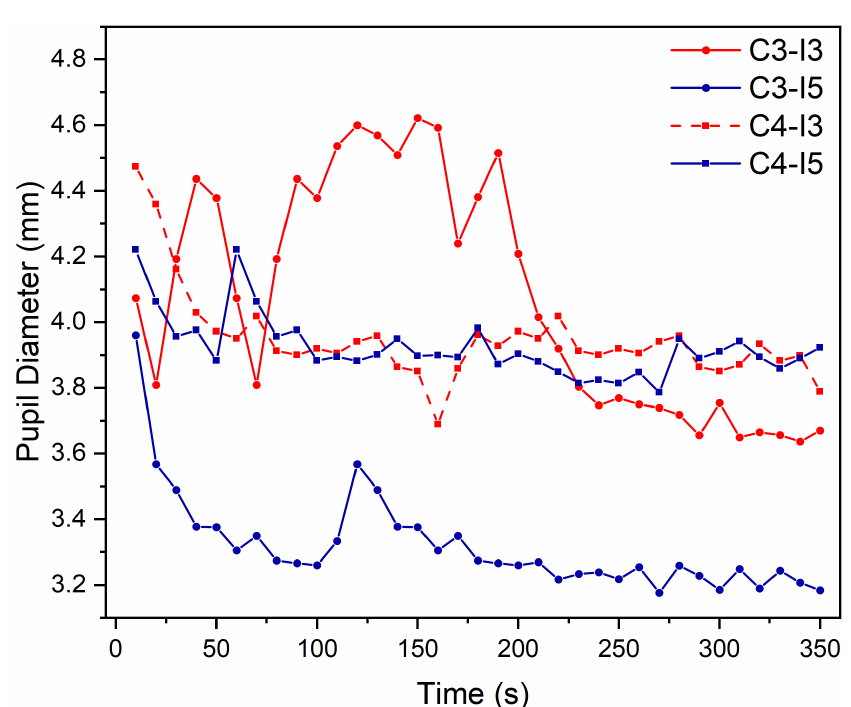
Figure 10. Pupil diameter in different lighting